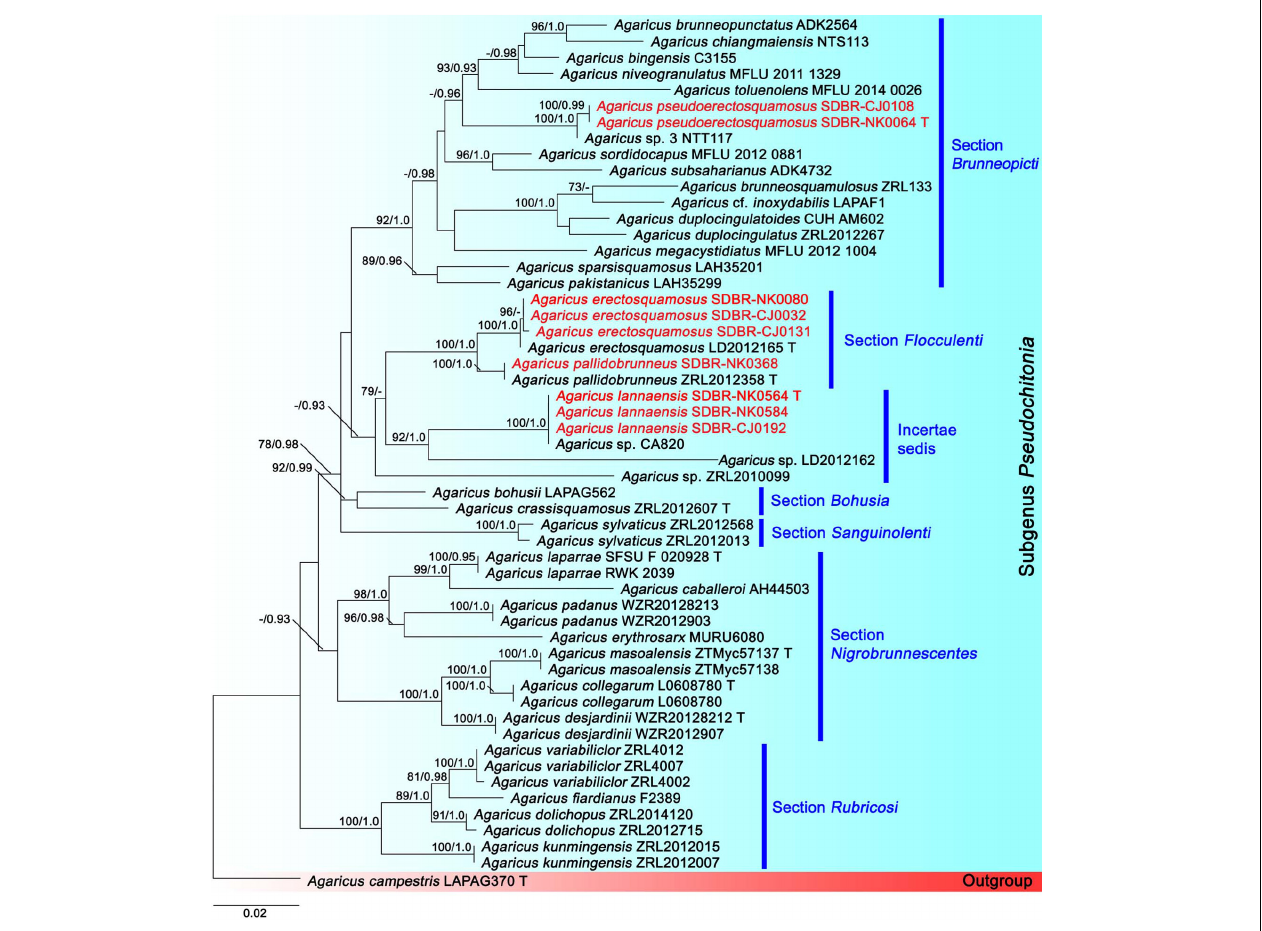
FIGURE 2 | Phylogenetic tree of the genus Agaricus generated from maximum likelihood based on multigene sequences (ITS, LSU, tef 1 exons, and tef 1 introns) of six sections in Agaricus subg. Pseudochitonia namely, Agaricus sect. Bohusia , Agaricus sect. Brunneopicti , Agaricus sect. Floculenti , Agaricus sect. Nigrobrunnescentes , Agaricus sect. Rubricosi and Agaricus sect. Sanguinolenti . Agaricus campestris was used as an outgroup. The vouchers from this study are in red and “T” means type specimen. Bootstrap support values (BS ≥ 70%) and posterior probabilities (PP ≥ 0.90) are presented above the supported branches.